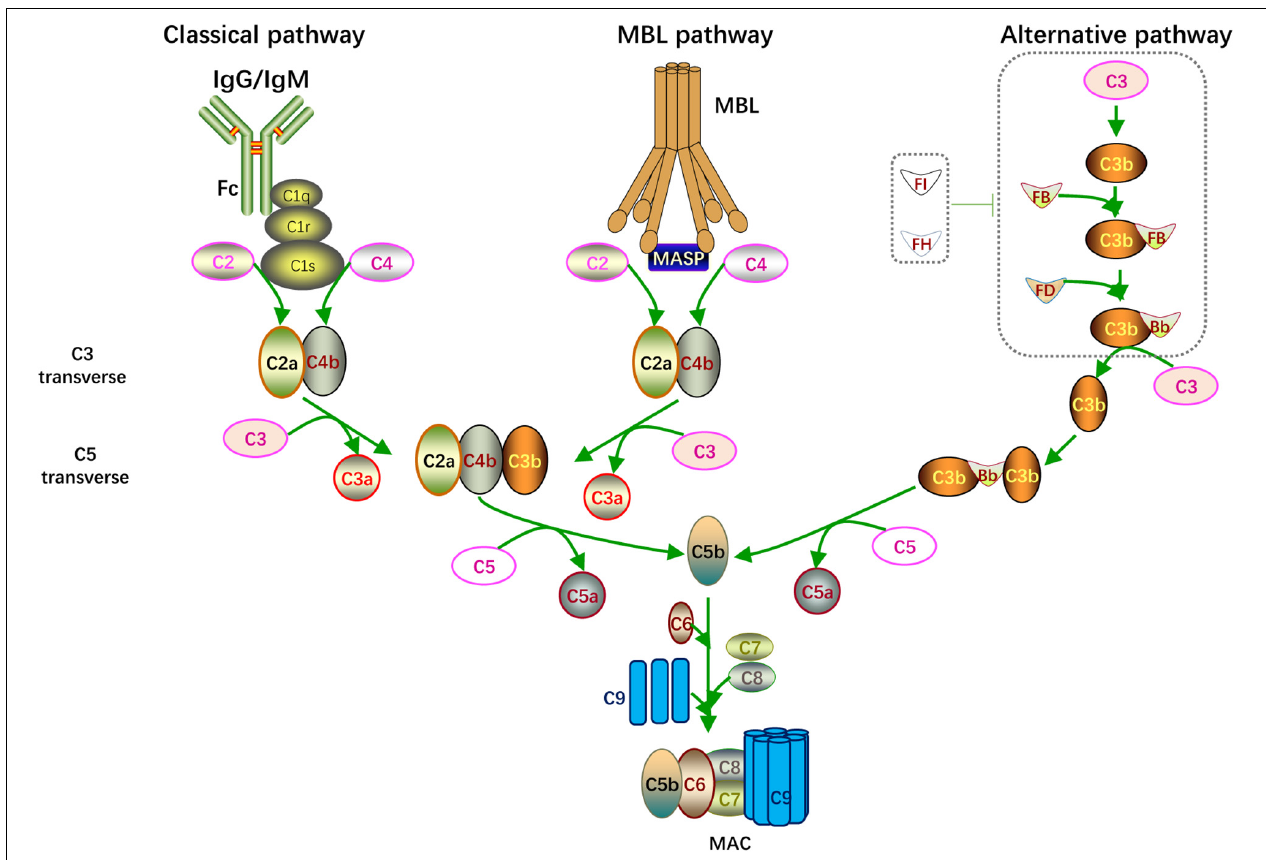
FIGURE 1 | Complement activation. Overview of the complement activation. There are three different pathways including classical pathway (initiated by IgG/IgM), MBL pathway (activated when MBL binding to MASP) and alternative pathway (microorganism components enhanced C3 autohydrolyzation and accumulation of C3 transverse). The catalytic activity of C3, C5 transverse and formation of C5b-9 complex (MAC) are common feature of these